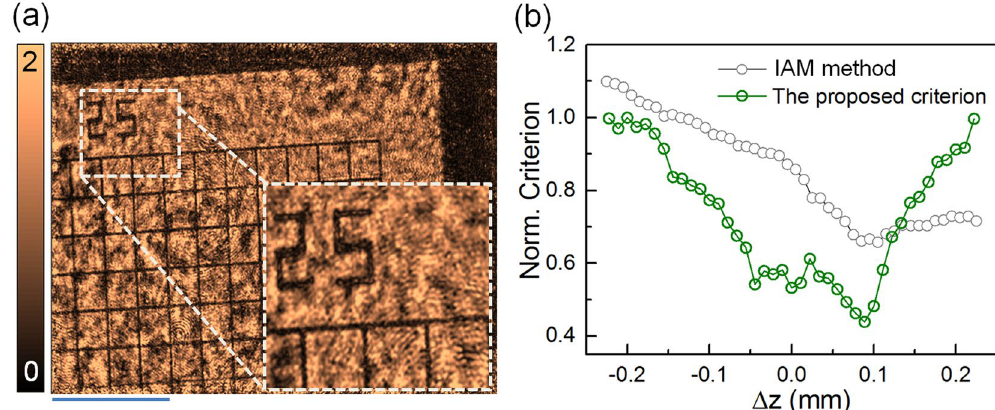
Figure 4. OV-DHM for amplitude sample. ( a ) Reconstructed amplitude of the sample; scale bar 75 μ m; the inset in ( a ) shows the zoomed image of the rectangular area indicated with the dash square. ( b ) Focus criterion curves calculated with the proposed method and the integrated amplitude modulus based method, for which the integral of the amplitude modulus is minimized when the focused plane is reached 6 .